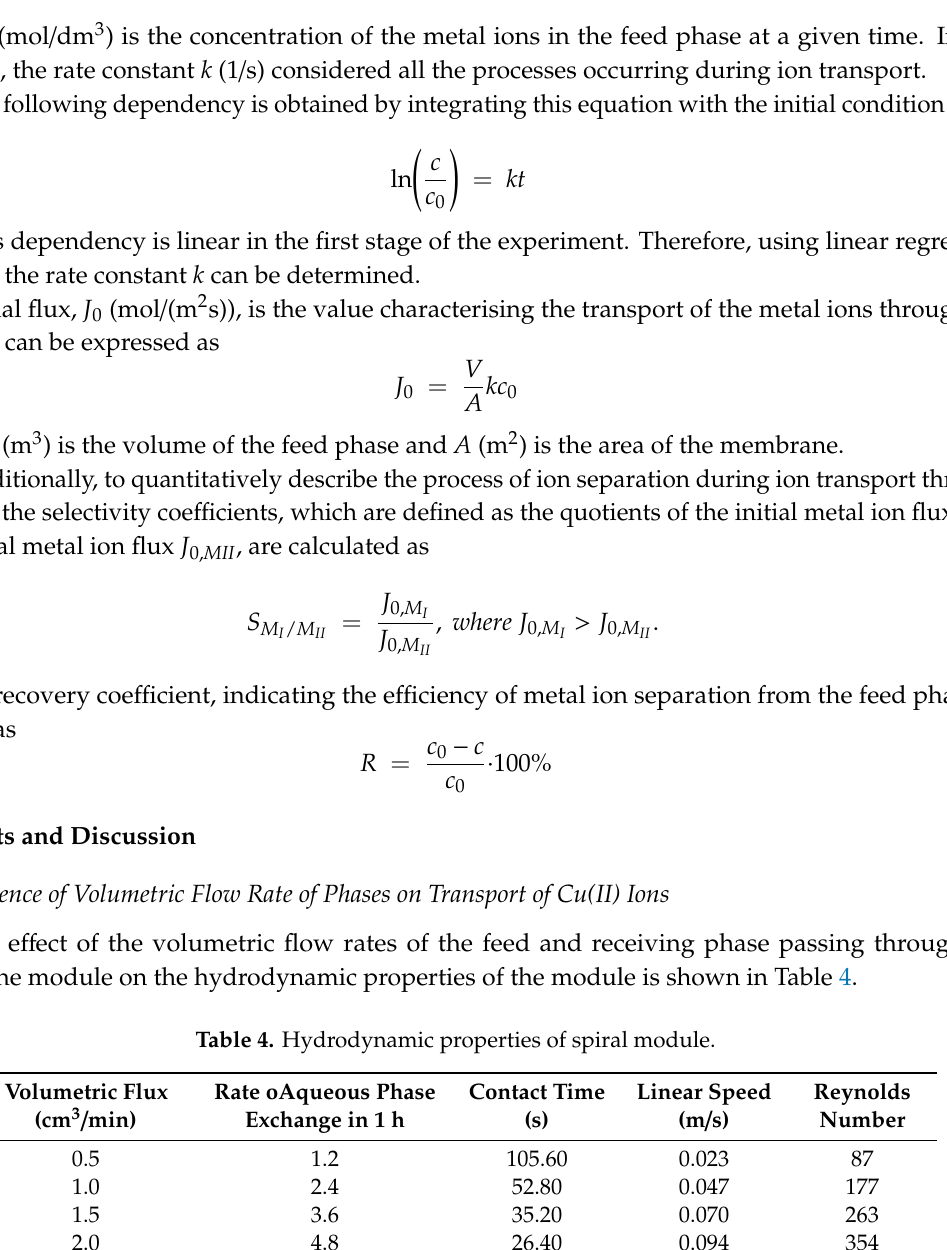
Table 2. Temperature: 20 ± 0.5 ◦